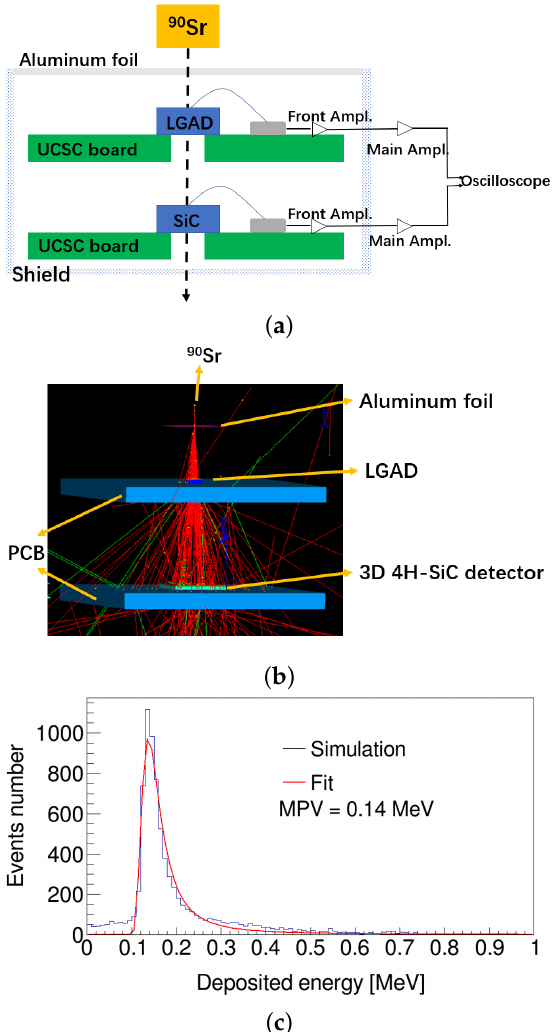
Figure 3. (Color online) ( a ) β -setup used to measure the time resolution of 4H-SiC detector. ( b ) GEANT4 simulated two electrons passing through aluminum foil, the LGAD, a printed cir- cuit board (PCB), and the 3D 4H-SiC detector. The tracks of electrons and the deposited energy with a step less than 1 µm were recorded. ( c ) Simulation of deposited energy distribution using 10,000 events in the 3D 4H-SiC detector, and the MPV was 0.14